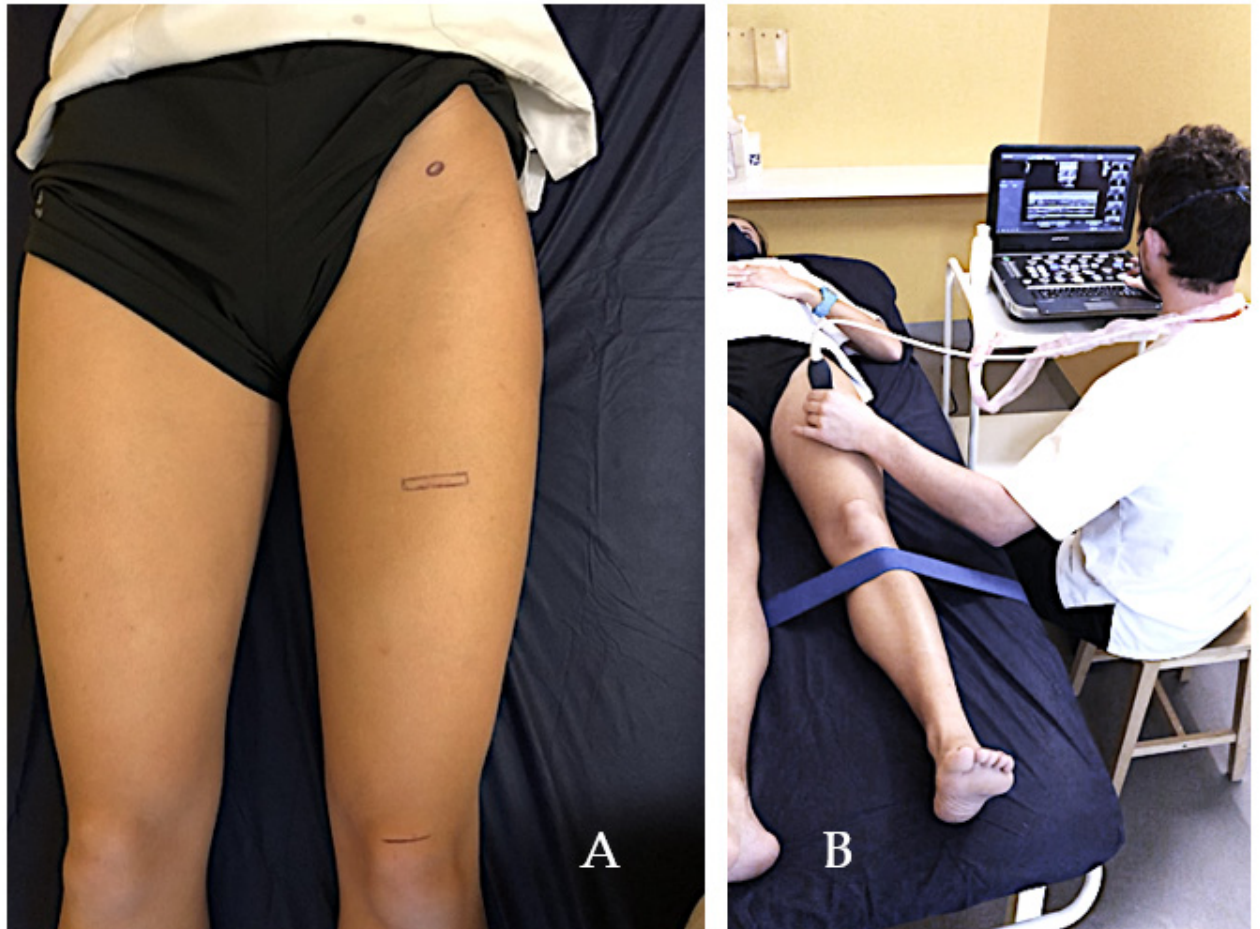
Figure 2. Researcher and patient preparations and positioning. Surface references ( A ) and ultra- sound assessment sampling ( B ). assessment sampling ( B